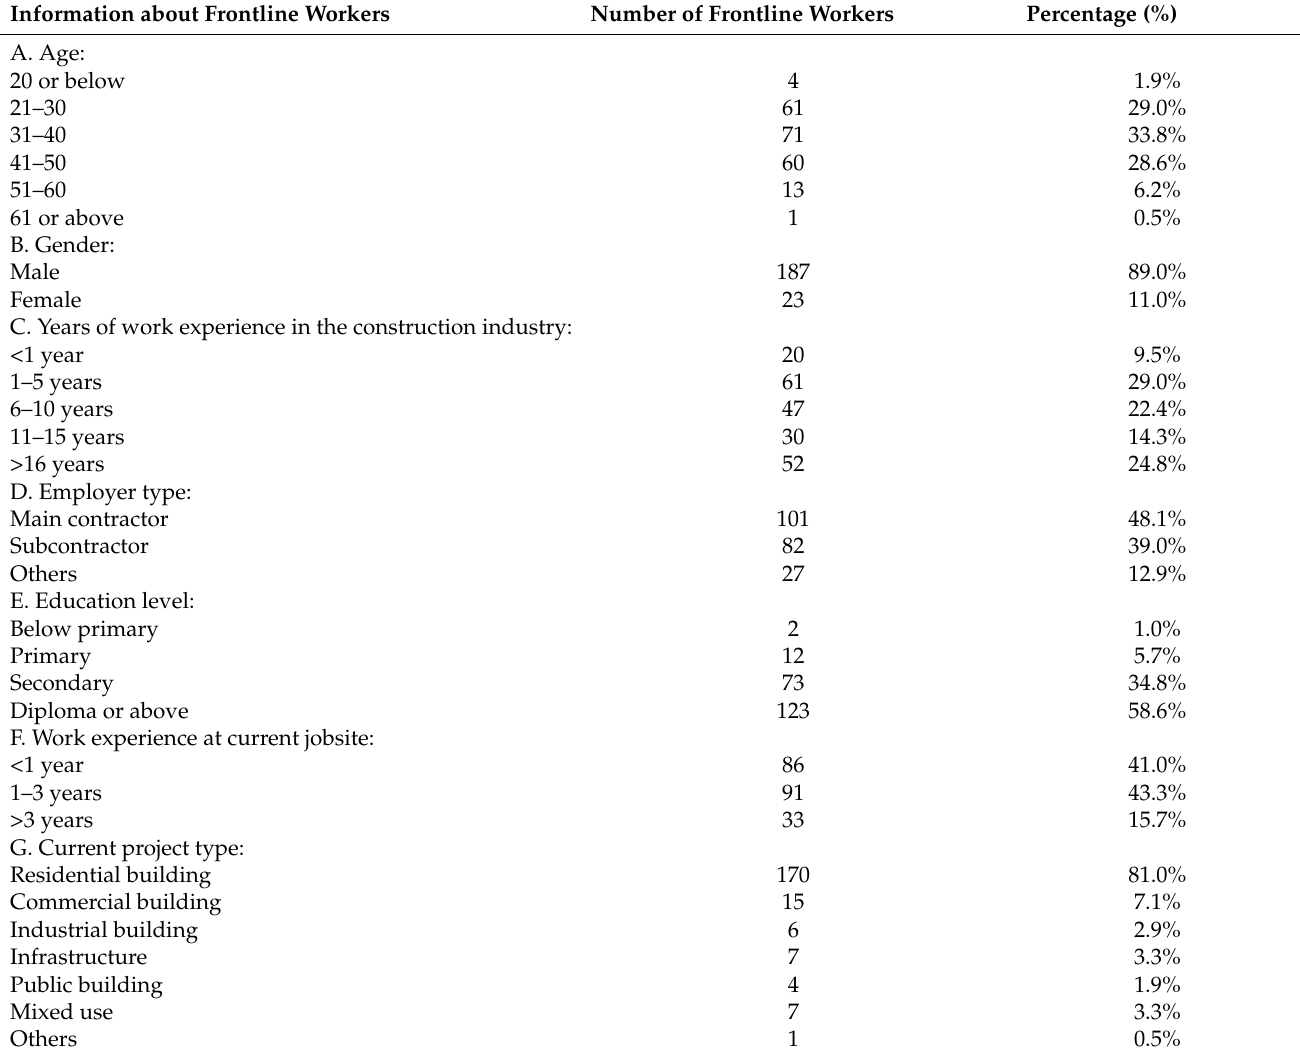
Table 4. Demographic information of 210 frontline